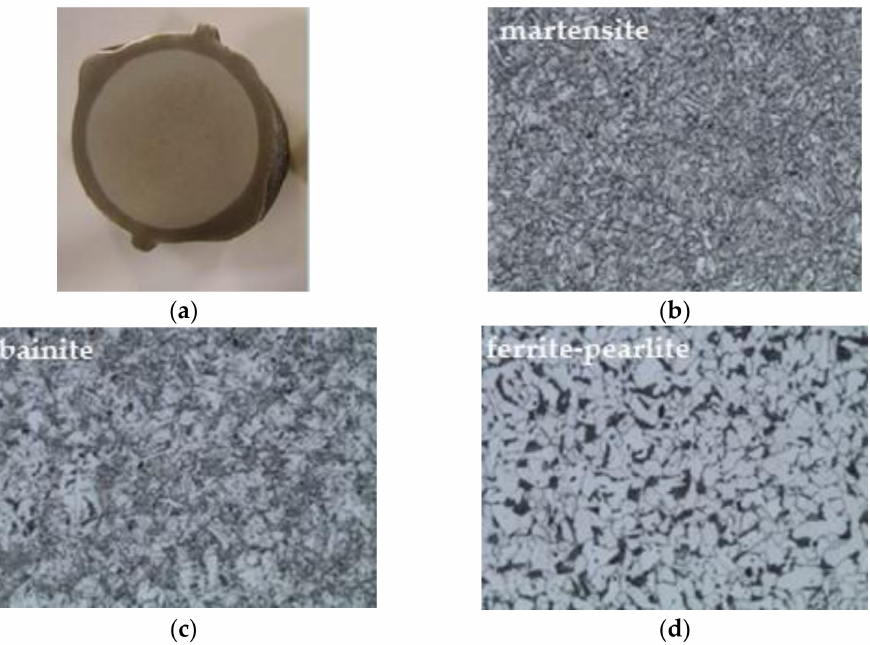
Figure 2. Discrete phases of martensite ( b ), bainite ( c ), and ferrite–pearlite ( d ) on a cross section of Tempcore B rebar ( a